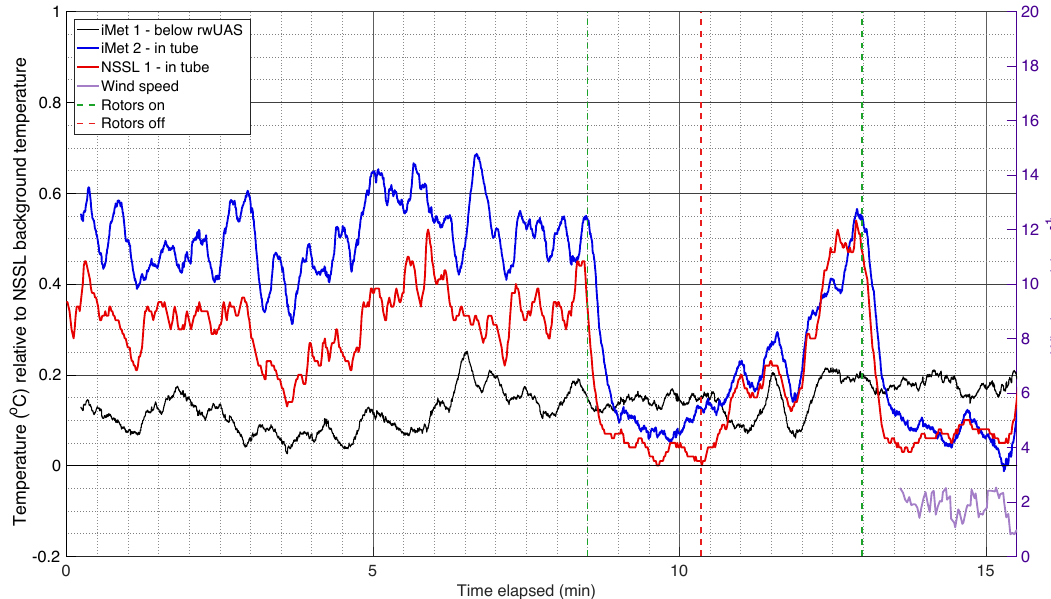
Figure 6. Temperatures ( ◦ C) relative to NSSL background temperature at the beginning of Experiment 1. This perspective emphasizes sensor self-heating (in addition to bias from the hot-wire anemometer) as the propellers are throttled on and off (green and red vertical dashed lines, respectively). Furthermore, the initial difference between NSSL sensors can be attributed to the presence of the anemometer in the radiation shield. While wind speeds were not recorded during this time, it is reasonable to extrapolate the 2.5ms − 1 reading backwards from minute 13.6 as the sensor position was